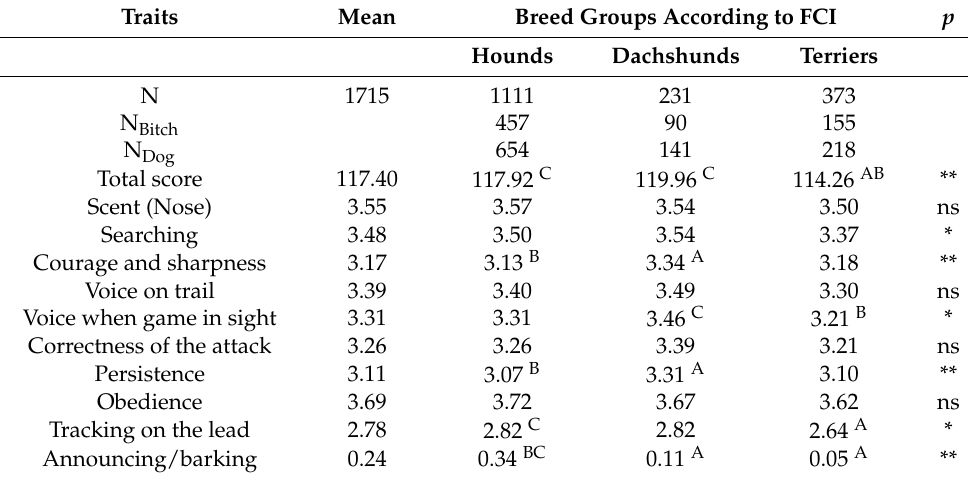
Table 4. The impact of breed groups on the results of the hunt trials for boarhounds. Traits Mean Breed Groups According to